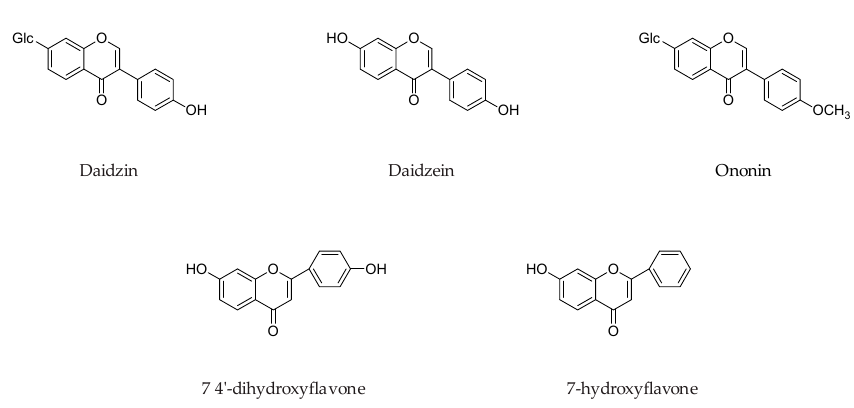
Figure 14. Chemical structures of isoflavone daidzein and its various analogs.